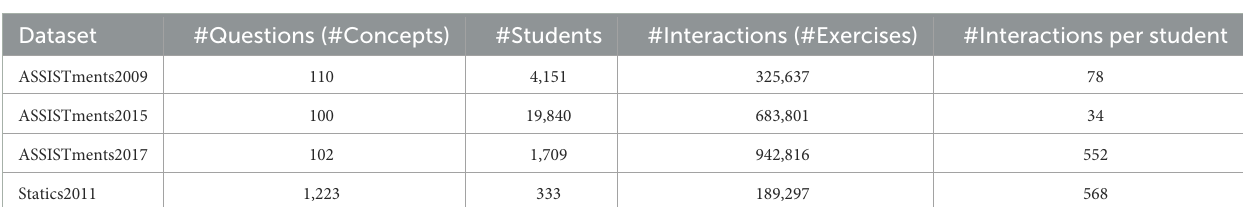
TABLE 2 Statistics of the